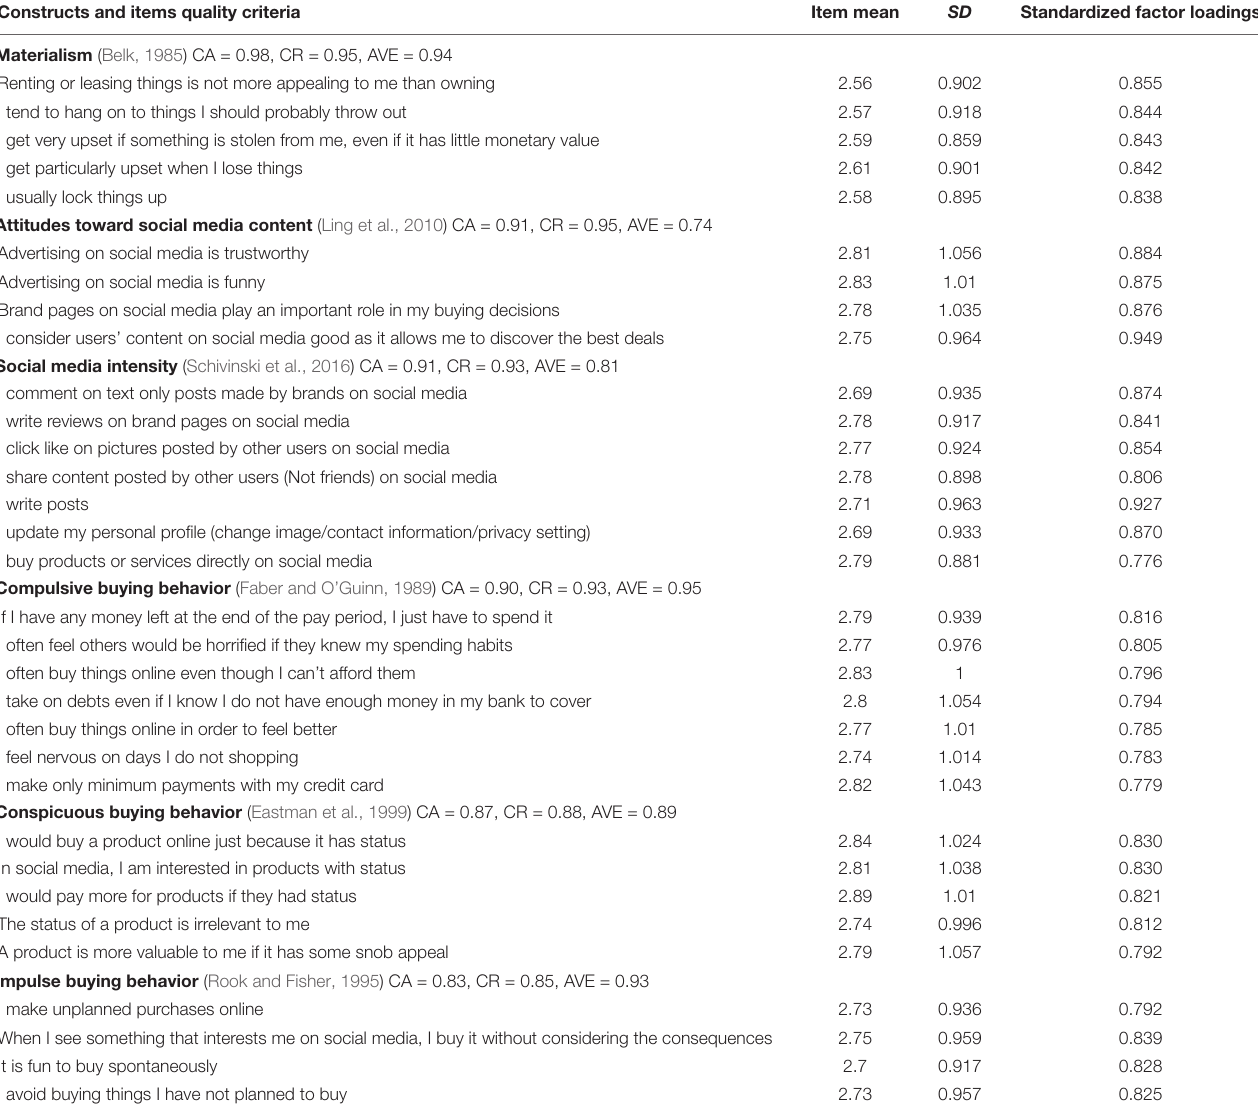
TABLE 2 | Evaluations of measures. Constructs and items quality criteria Item mean SD Standardized factor